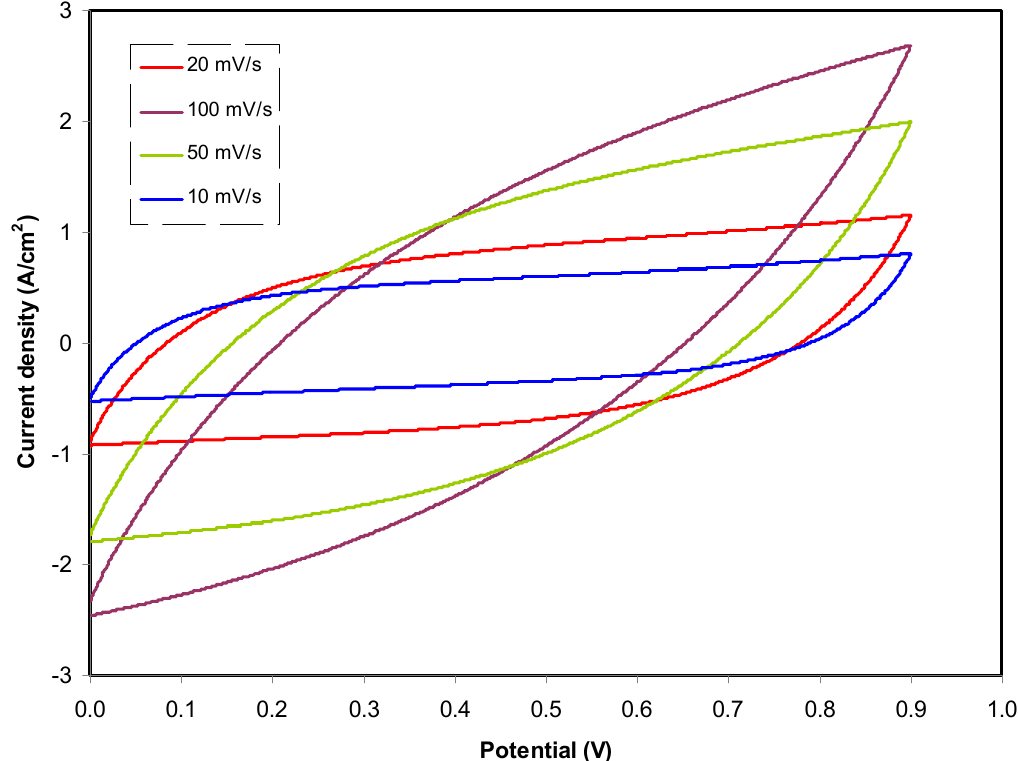
Figure 8. CV plot of the constructed EDLC at different scan rates from 0 V to 0.9 V.